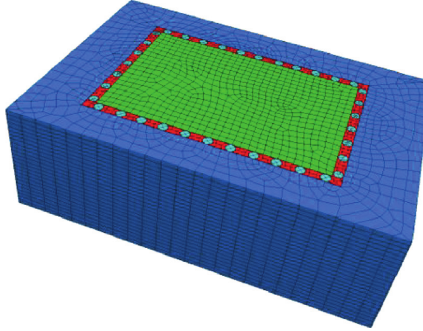
Figure 10: Foundation pit Table 4: Material parameters.